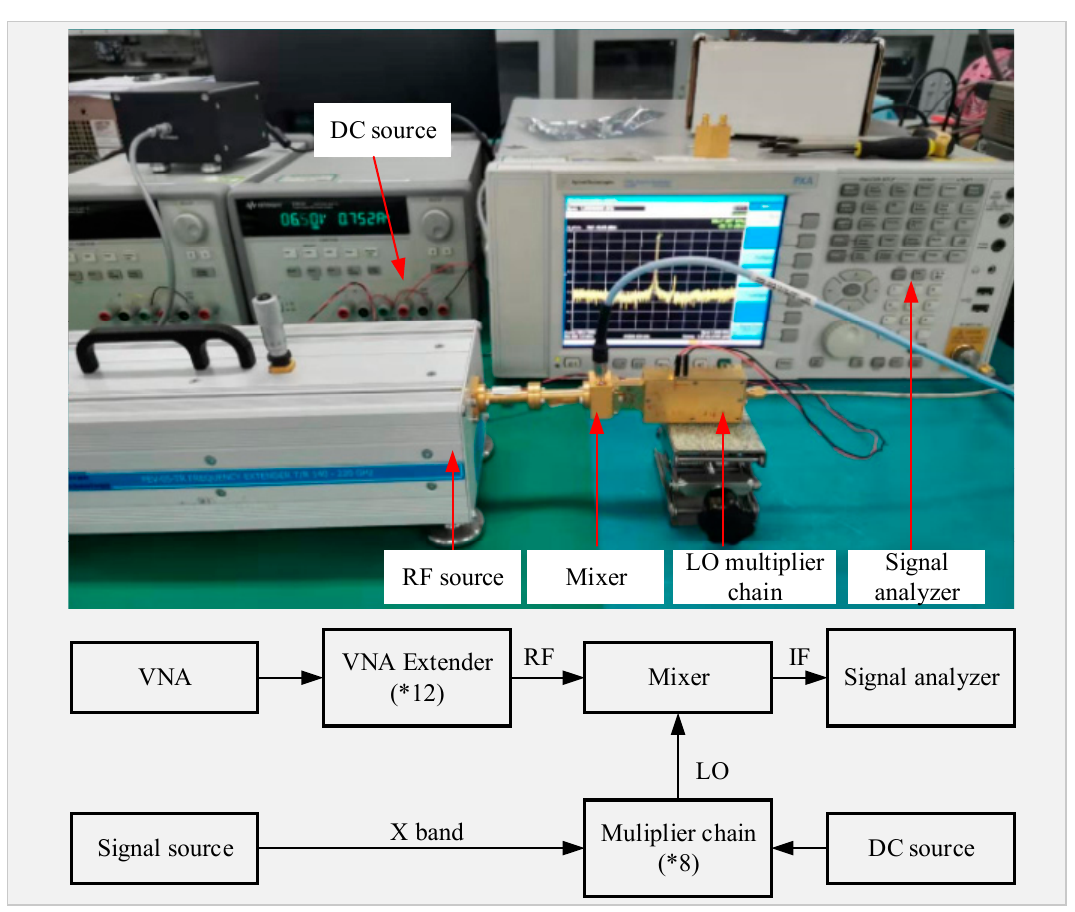
Figure 13. Test diagram and test bench of the 183 GHz mixer.